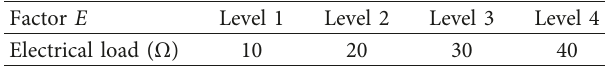
Table 6: Other key specifications of the HERSA.